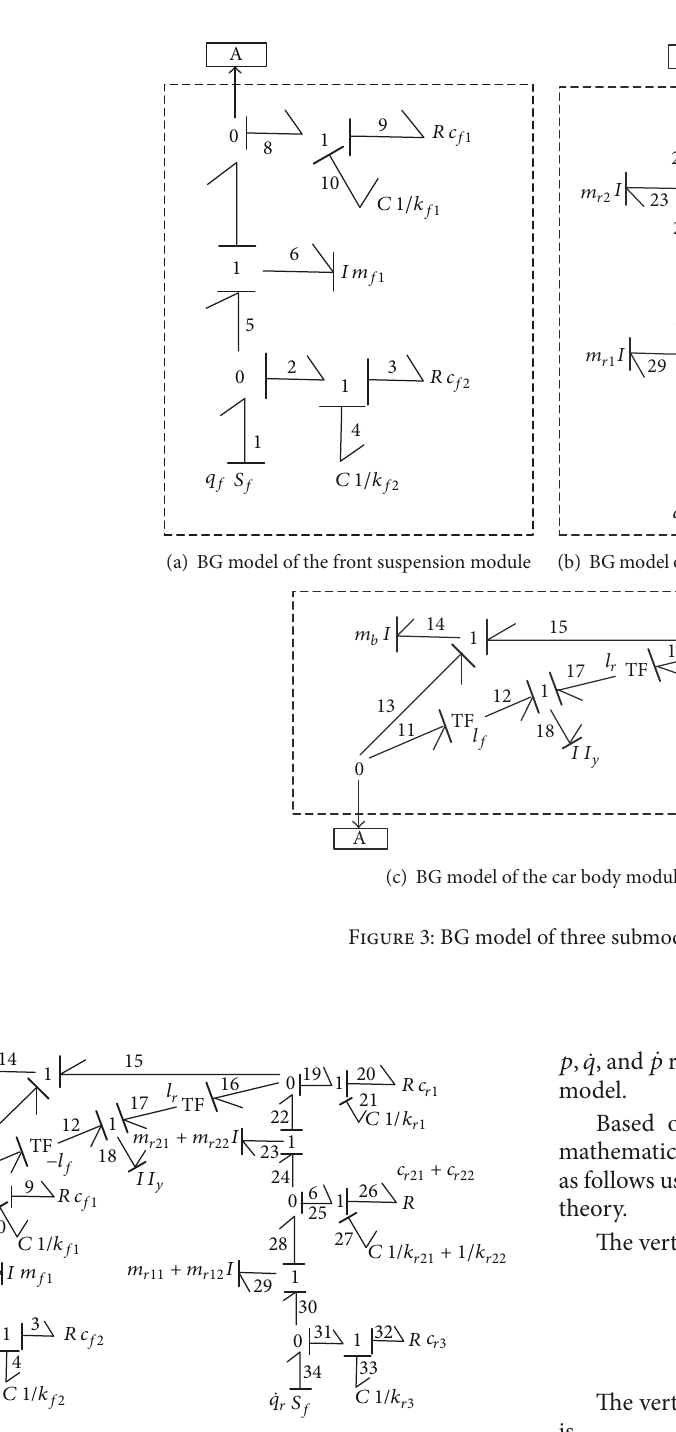
Figure 4: BG model of the 1/2 vehicle.